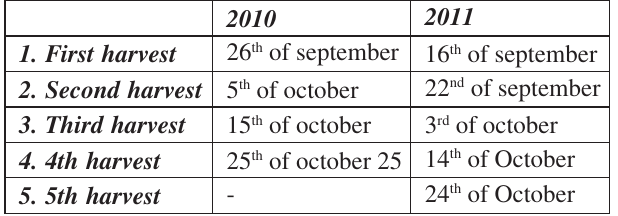
Table 1:. Dates of the samplings (harvests) in both examined years